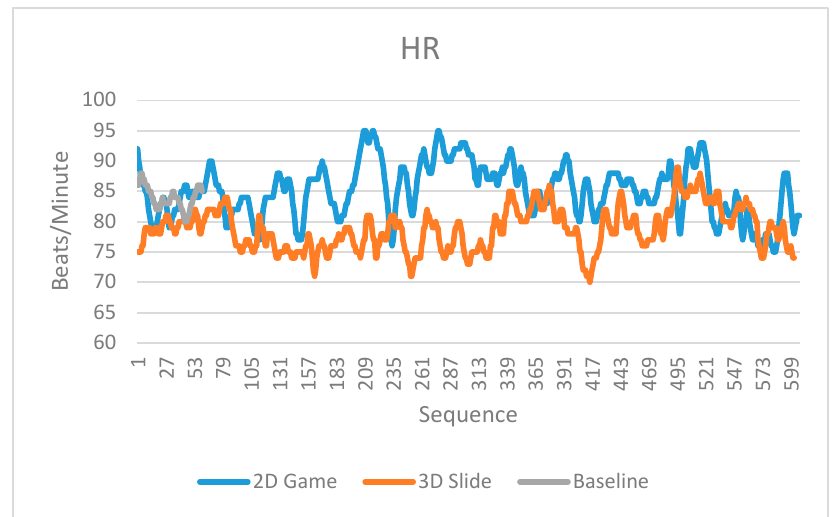
Figure 8. Heart rate readings in the baseline, 2D game, and 3D slide.